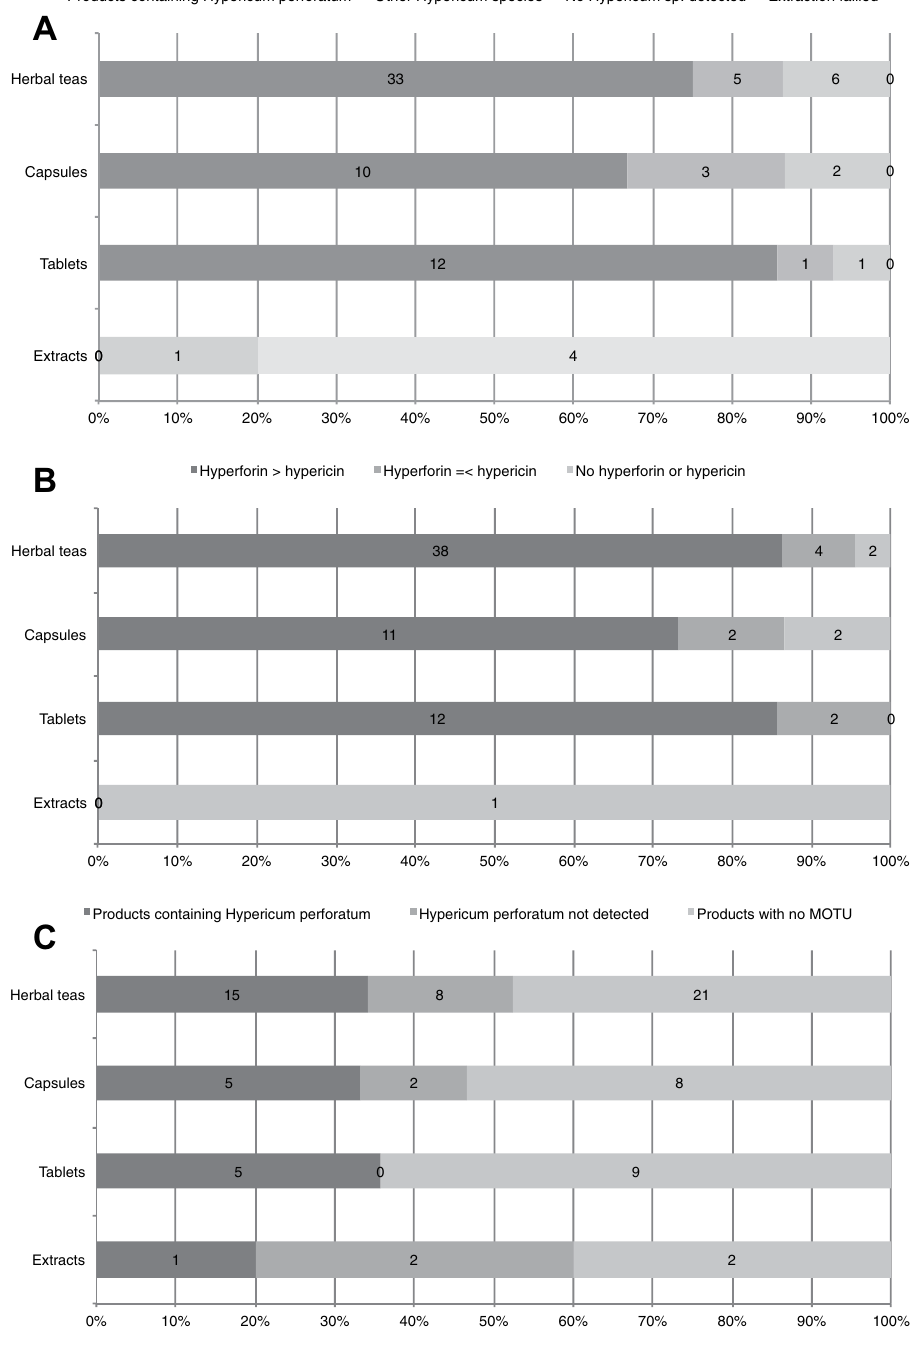
Figure 2. Presence of Hypericum perforatum within the products. ( A ) Detection using thin layer chromatogram (TLC). ( B ) Detection using high-performance liquid chromatography-mass spectrometry (HPLC-MS). ( C ) Detection using amplicon metabarcoding (AMB). Detection between methods is not fully comparable as the resolution of the approaches